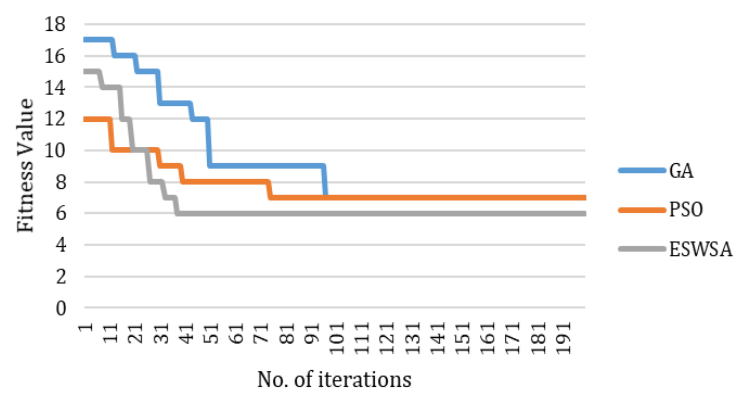
Figure 5. Convergence plot of ESWSA